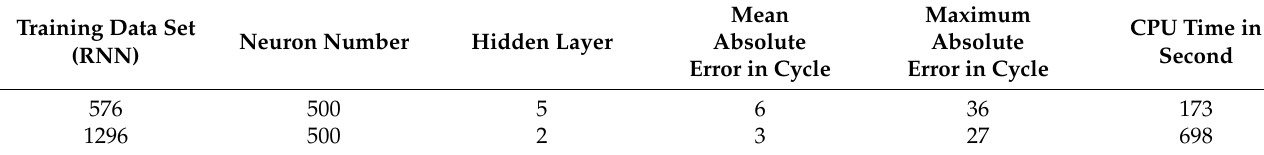
Table 13. Comparison of RNN regression results for